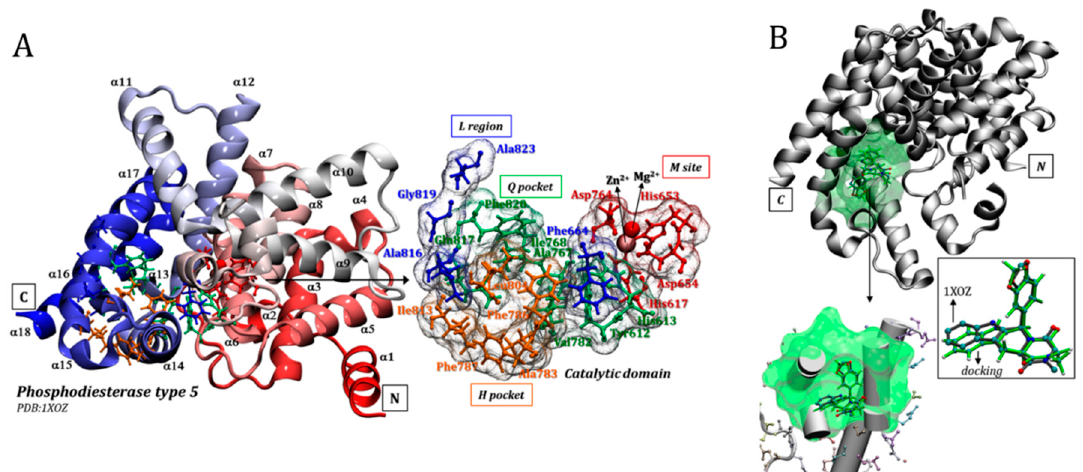
Figure 1. Details of the three-dimensional structure of the phosphodiesterase type 5 (PDE5) enzyme: ( A ) highlighting some amino acid residues that make up the catalytic domain and ( B ) comparative redocking of the conformational arrangements of the tadalafil inhibitor in the crystallographic structure (in grey) and using the molecular docking protocol (highlighted in green).